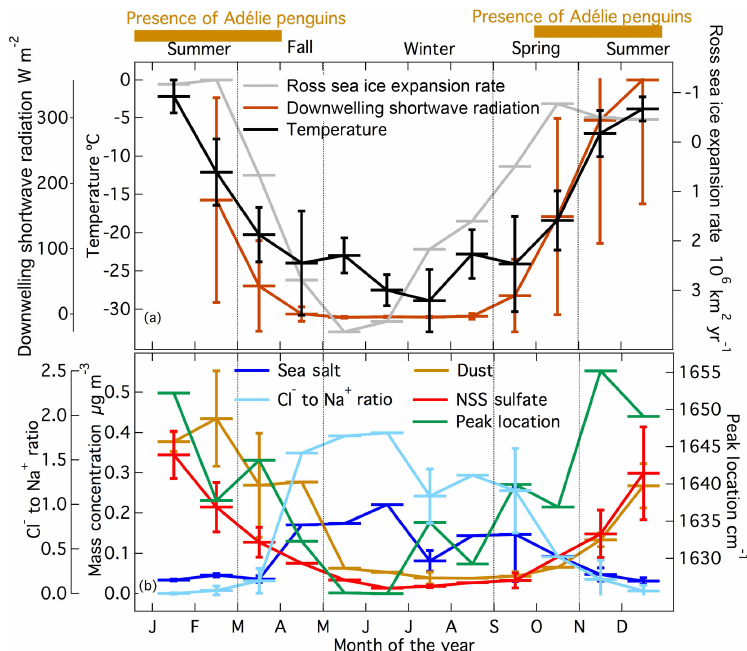
Figure 1. Monthly average of (a) temperature, shortwave downwelling irradiance measured in this study, and sea ice expansion rate of the Ross Sea (Holland, 2014); (b) Sea salt, dust, and non-sea salt sulfate concentration from XRF and FTIR peak location at 1500–1800cm − 1 wavenumber region. Standard deviations are shown on the plot as error